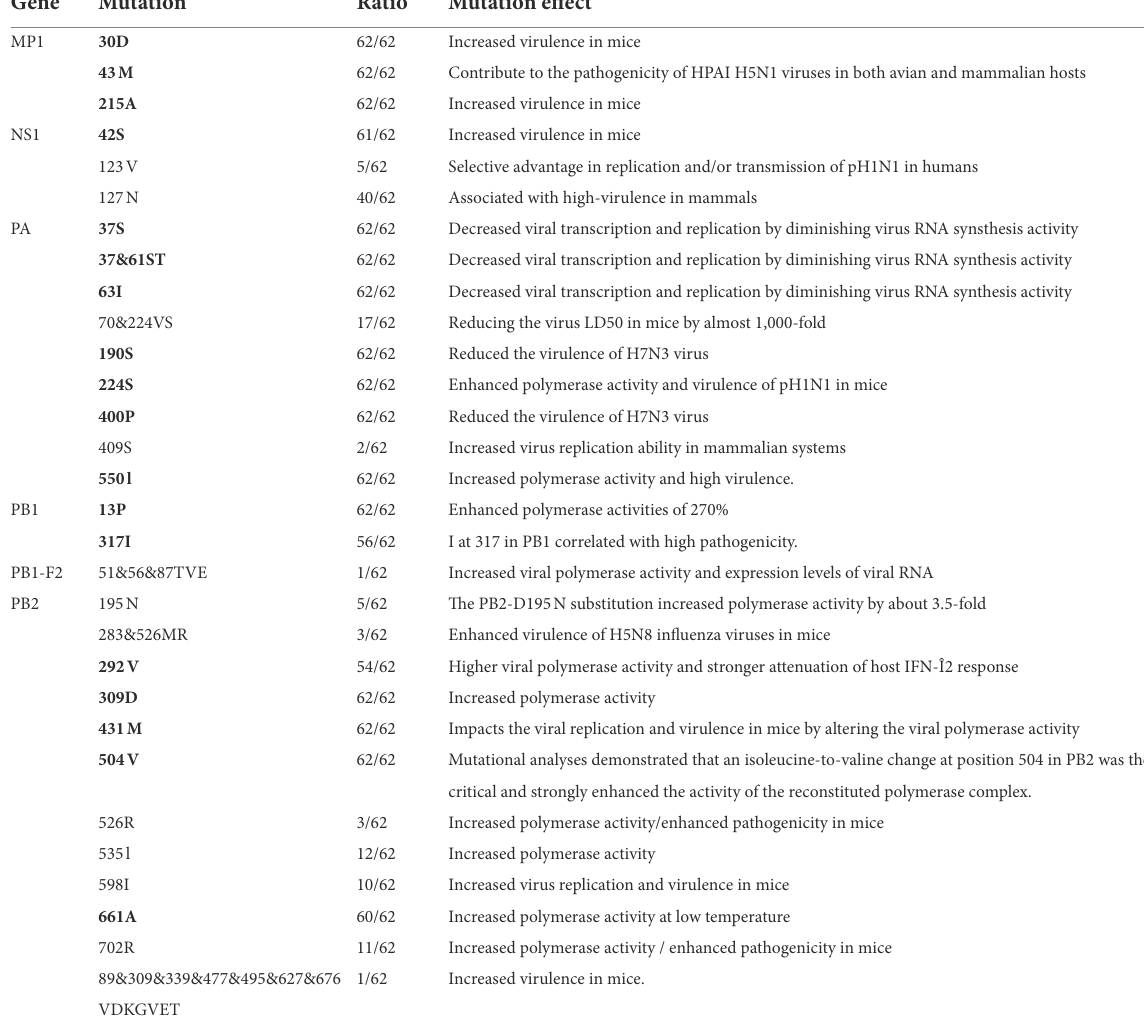
TABLE 3 The mammalian-virulence-related molecular markers identified in the newly sequenced H9N2 strains. Gene